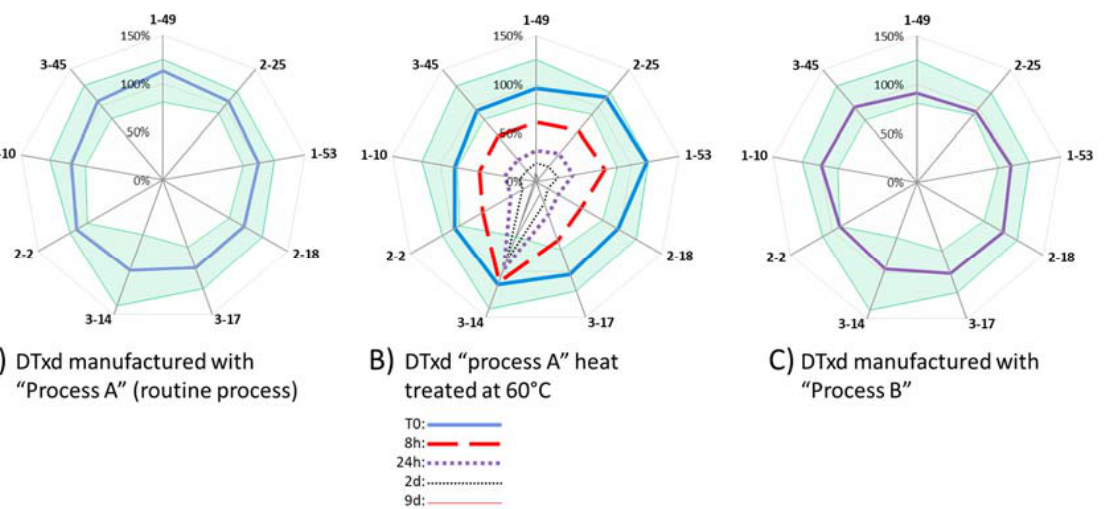
Figure 4. Epitope profile of DTxd material defined by SEAT using nine mAbs. SEAT using mAbs 1-49, 2-25, 1-53, 2-18, 3-17, 3-14, 2-2, 1-10, and 3-45 were used to determine the antigenicity (%Recovery) of DTxd. Comparability range (green area) was defined by the average antigenicity ± 3 SD for nine